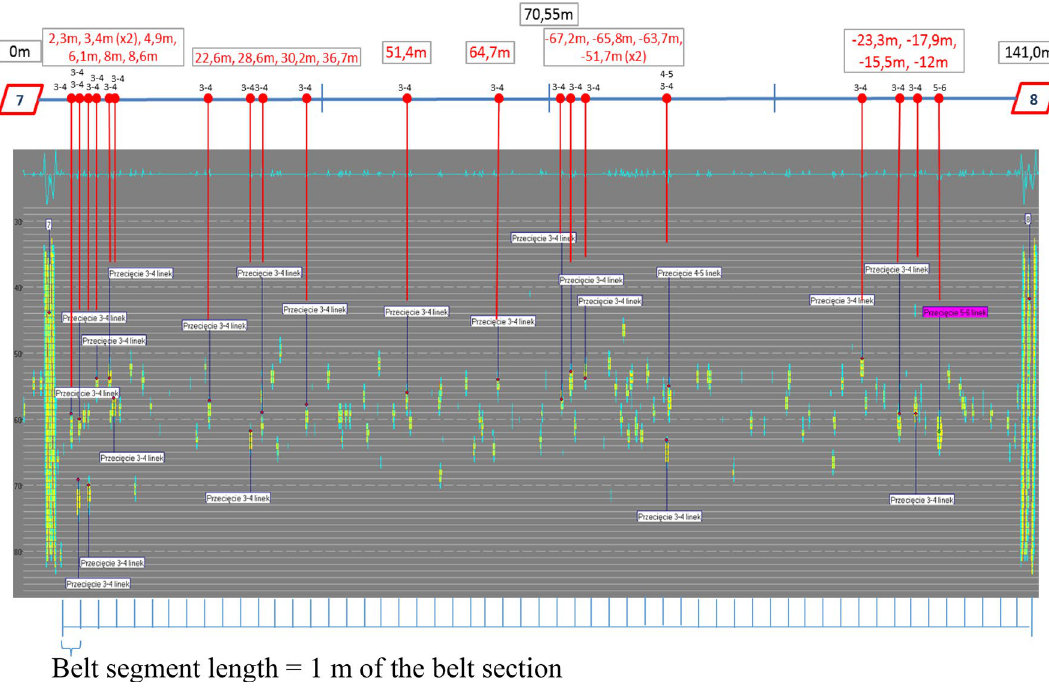
Figure 8. Two-dimensional image of core damage in the belt section with 1-m segments, which served to calculate damage—state of March 2018 5,42 (screenshot of Belt Analysis software version 0.6, http:// www. belts can.